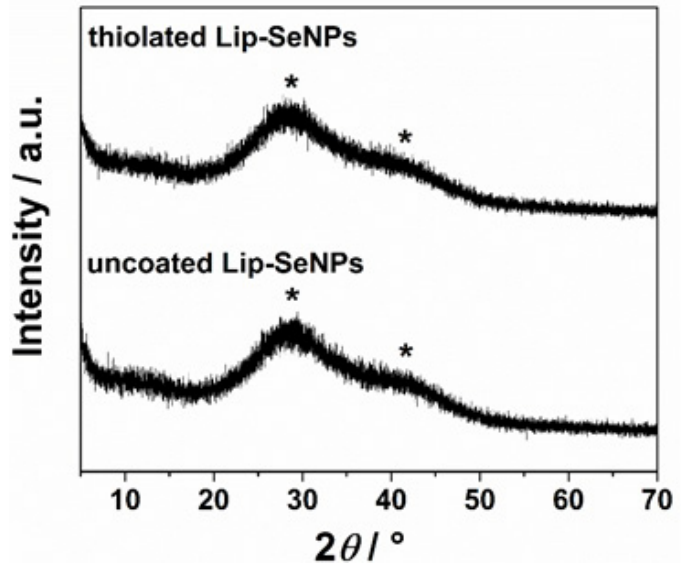
Figure 5. PXRD diffraction pattern of Lip-SeNPs. The stars (*) indicate the positions of the diffraction peaks corresponding to (101) and (110) lattice planes, respectively.